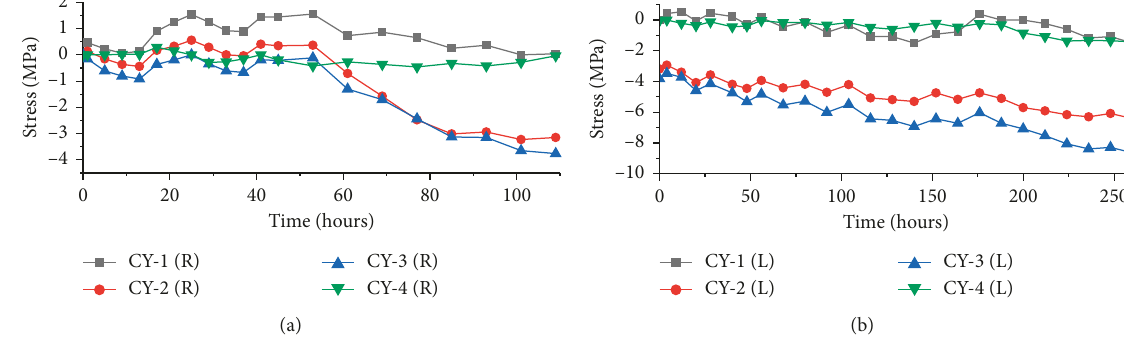
Figure 10: Time history curves of initial support stresses of the right tunnel tube: (a) after the excavation of the right tunnel tube; (b) after the excavation of the left tunnel tube.